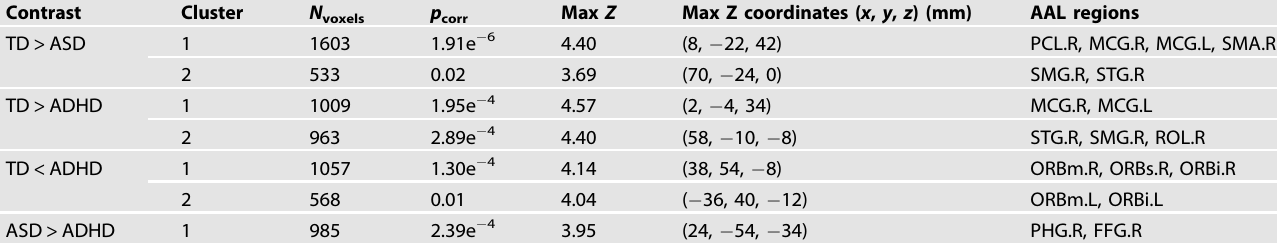
Table 5. Brain regions showing signi fi cant between-group differences in the social help > social threat contrast ( Z > 2.3, p corr <